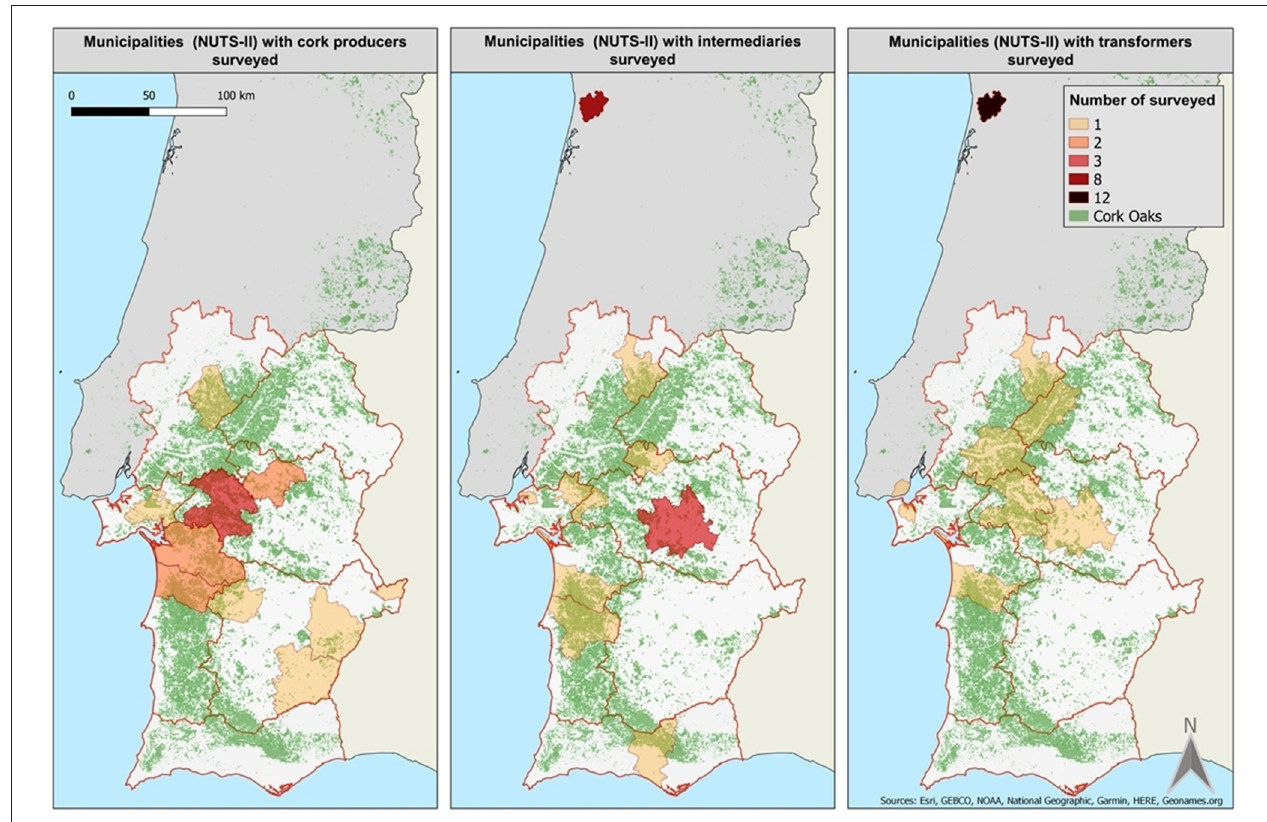
FIGURE 3 | Display of the density according to the location of respondents. Winemakers are not represented as these are distributed all over the